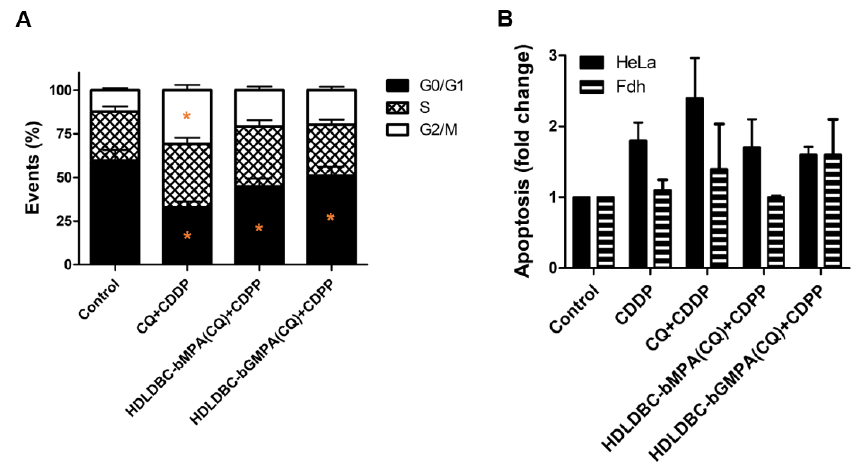
Figure 9. Cell cycle changes and induction of apoptosis was analyzed by flow cytometry after treatment with 40 µM of free CQ or CQ encapsulated in HDLDBC-bMPA for 18 h and/or 1 µg/mL of CDDP for an additional 48 h. ( A ) HeLa cells were stained with propidium iodide (PI) and cell cycle distribution was measured after 72 h of treatment (* indicates alterations > 10% compared to control group). ( B ) HeLa cells and Fdh were double-stained with Annexin V-FITC/PI to detect the contribution of apoptosis and necrosis after treatment for 72 h. Apoptotic populations are presented as fold change of control group.